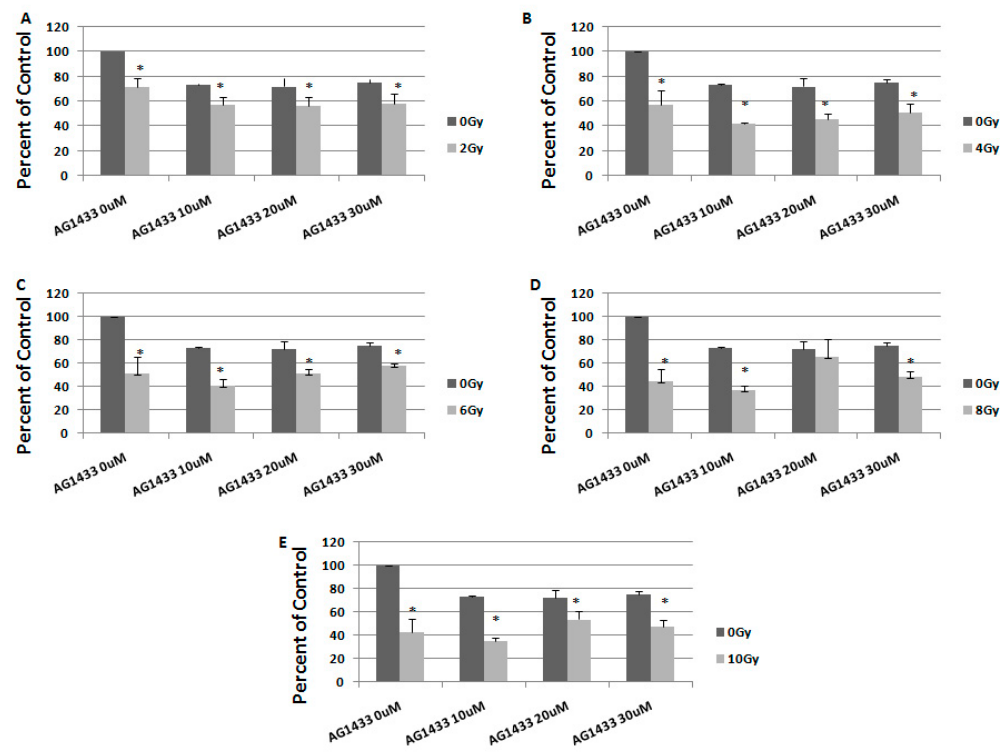
Figure 7. The e ff ect of PDGFR inhibition on ionizing radiation response in 15 HGG cells, 7 days after treatment. The cells were seeded in 96-well culture plates (3000 cells / well) then irradiated with 2 Gy ( A ); 4 Gy ( B ); 6 Gy ( C ); 8 Gy ( D ); 10 Gy ( E ) and treated with 10, 20, or 30 µ M AG556. The cells were